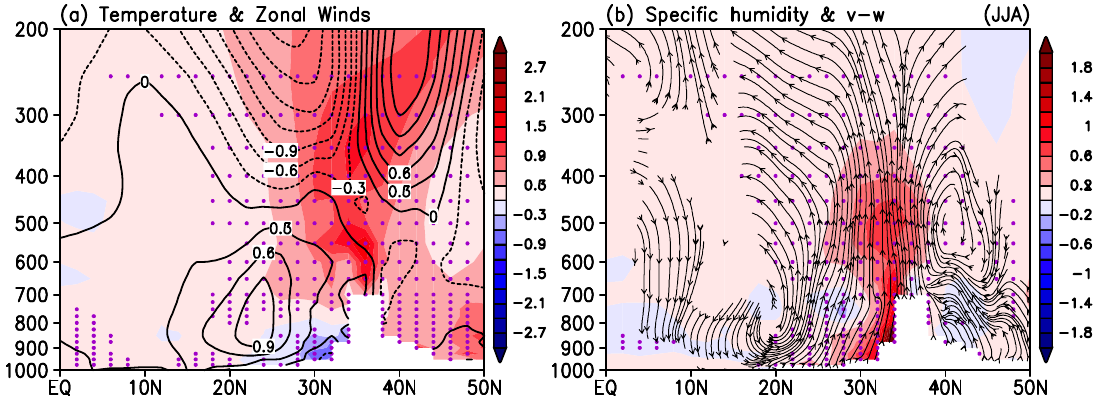
Figure 4. Height–latitude cross-section June–July–August mean anomalies, averaged over (70–90 ◦ E) for ( a ) temperature (°C) and zonal winds (m s −1 ), and ( b ) specific humidity (g Kg −1 ), and streamlines of anomalous meridional circulation. Purple dots indicate 95% statistical significance.